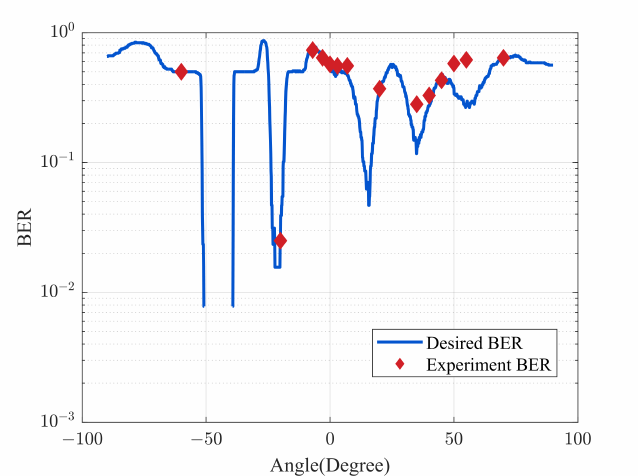
Figure 15. Comparison of the desired BER (blue) and the experimental BER